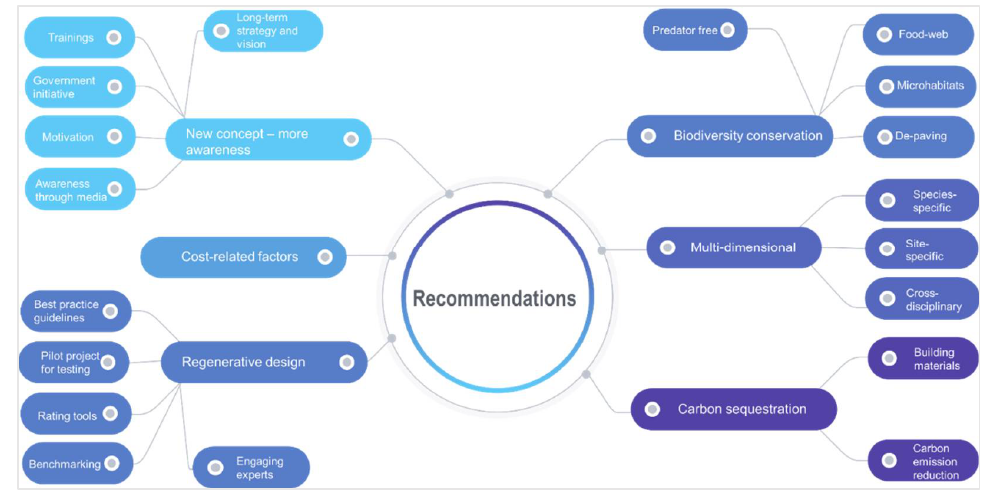
Figure 20. Additional information and recommendations.